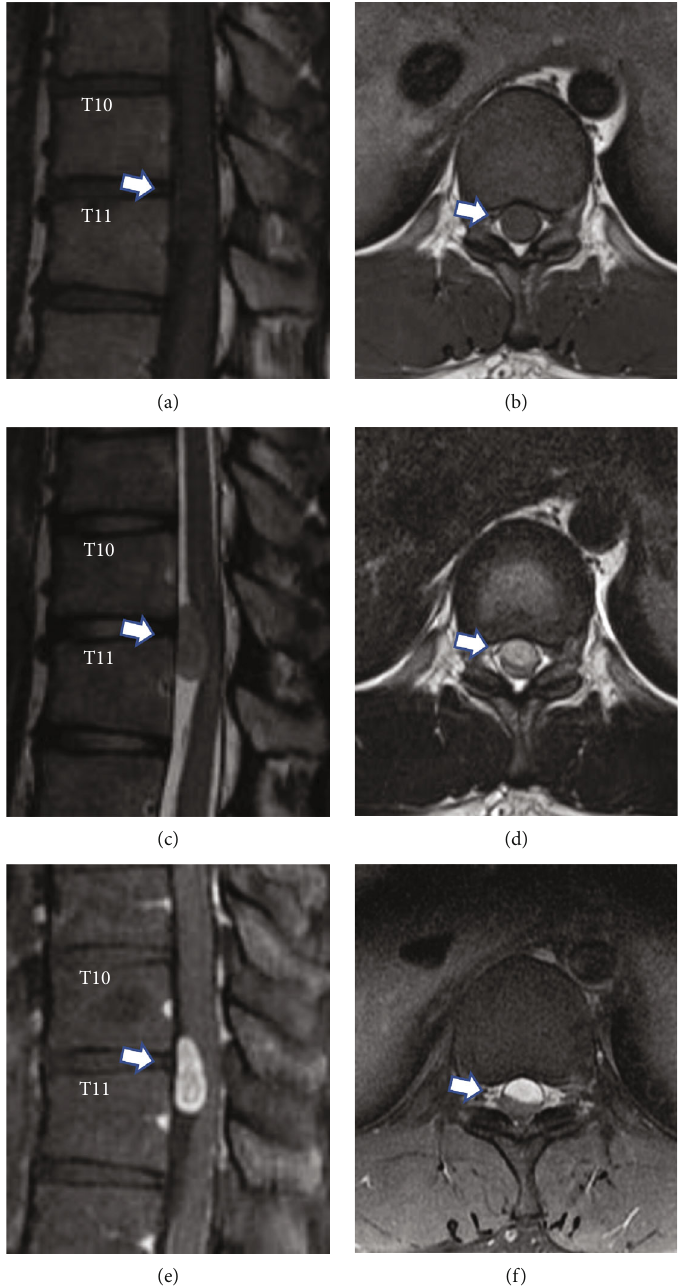
Figure 1: Magnetic resonance imaging of a 25-year-old man revealed an intradural extramedullary lesion at the T10 and T11 levels. The lesion shows hypointense in T1-weighted (a, b), isointense in T2-weighted (c, d) and heterogeneous in gadolinium enhancement (e, f) sagittal and axial magnetic resonance imaging of the thoracic spine. Arrows indicate the location of the